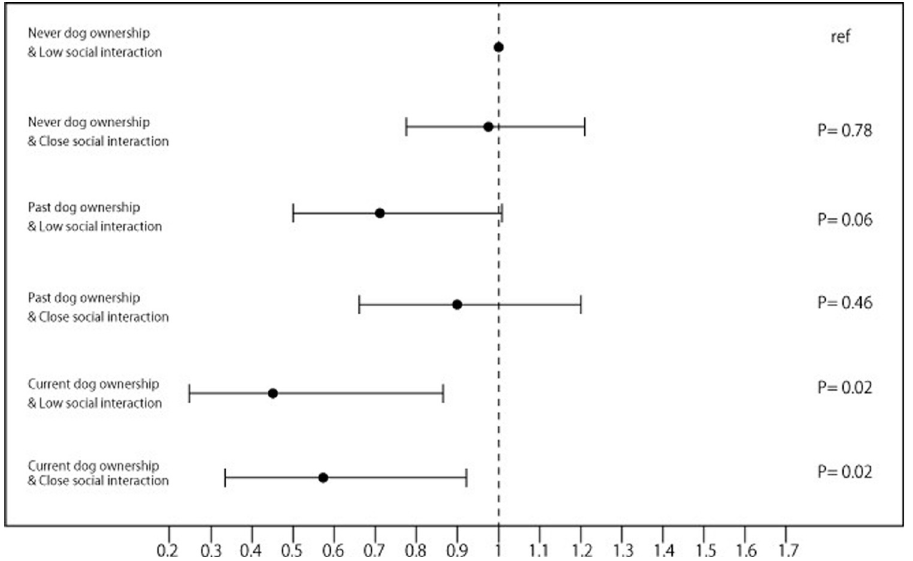
Fig 2. Odds ratios of dog ownership and social relationship with incident disability. Adjusted for socio- demographic variables (sex, age, household size, years of education, equivalent income, and administrative district), health measures (history of hypertension, heart disease, stroke, diabetes mellitus, lung respiratory disease, and cancer, alcohol drinking and smoking status, food variety, frailty, Geriatric Depression Scale), and follow-up